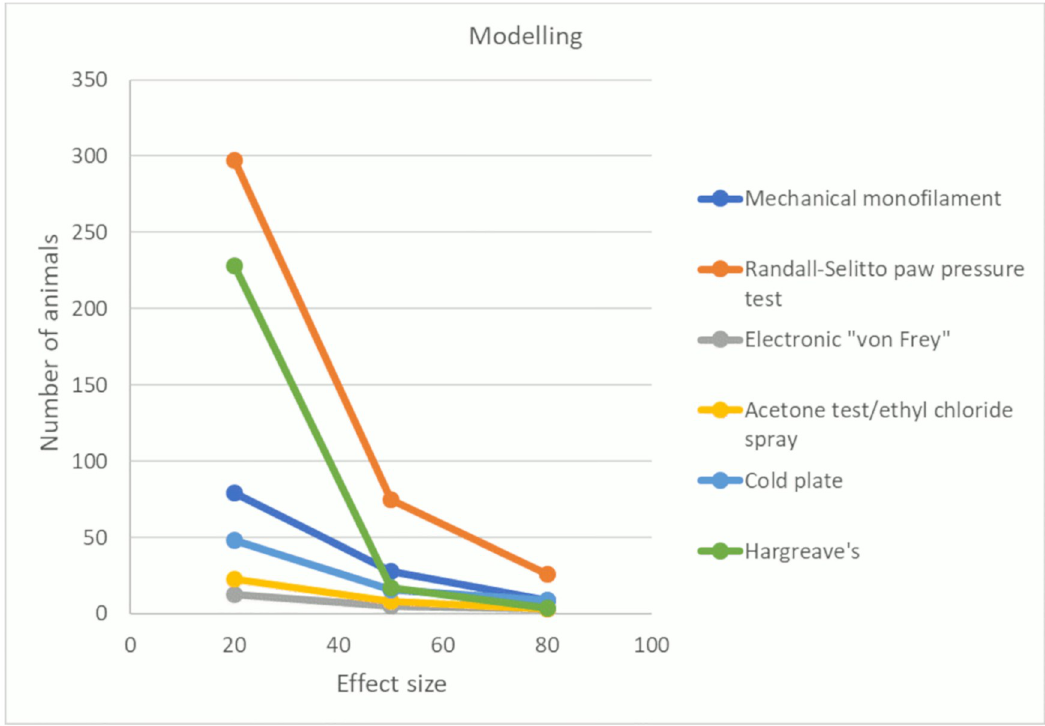
Fig 5. Power analysis for modelling experiments (data set 1a). Number of animals required per group to obtain 80% power with a significance level of 0.05 using mechanical monofilaments, Randall-Selitto paw pressure test, electronic ‘von Frey’, acetone test/ethyl chloride spray, cold plate, and Hargreave’s. Effect sizes calculated by SMD. SMD, standardised mean